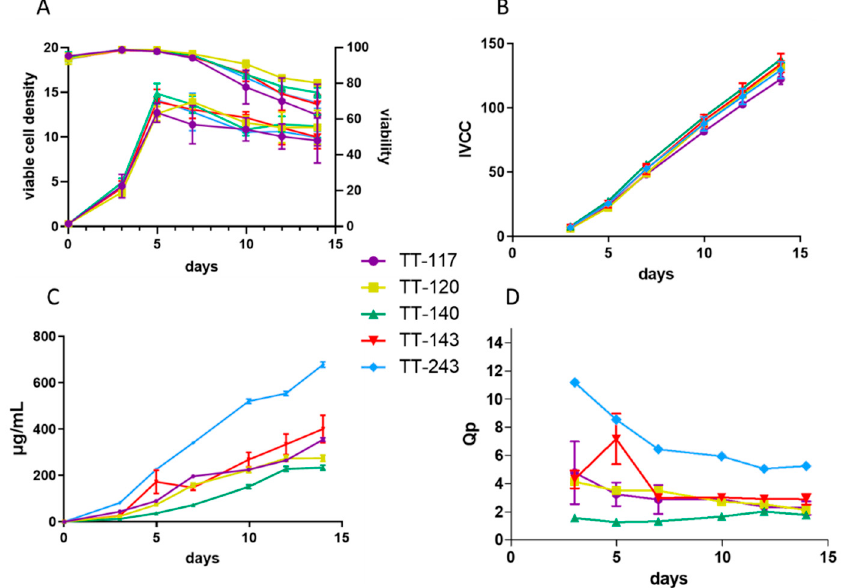
Figure 2. Graphs of fed-batch cultivation of stable transfection. Pools of mAbs were cultivated in a fed-batch mode for 14 days, with the evaluation of cell density and viability ( A ), IVCC ( B ), titer ( C ), and Qp ( D ). Each of the five mAbs is identified by the same color line. Graphs A and B, related to cell growth, show the mean and SD of data obtained by the four conditions of the selection agents for each mAb. Graphs ( C , D ), related to mAb production, show the quadruplicate of titers measured in the most stringent selection step.